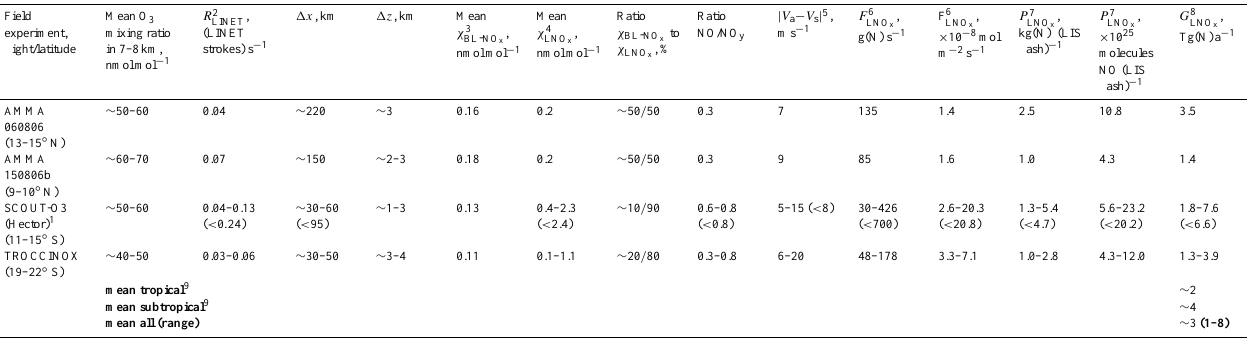
Table 4. Comparison of different parameters influencing LNO x based on results from the field campaigns AMMA (West Africa), TROCCI- NOX (Brazil) and SCOUT-O3 (North Australia), with values partly adapted from Huntrieser et al. (2007, 2008, 2009).